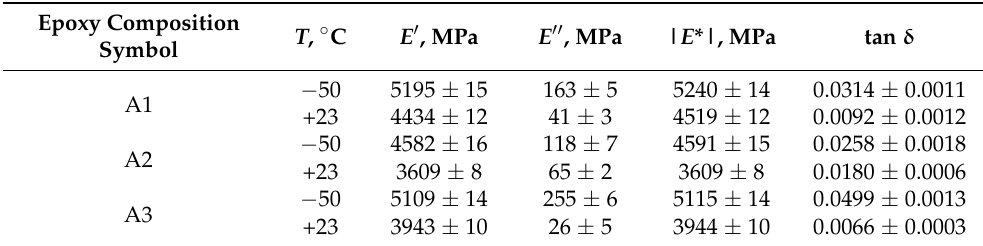
Table 2. The values of the complex module and its components for the adhesive compositions at the test